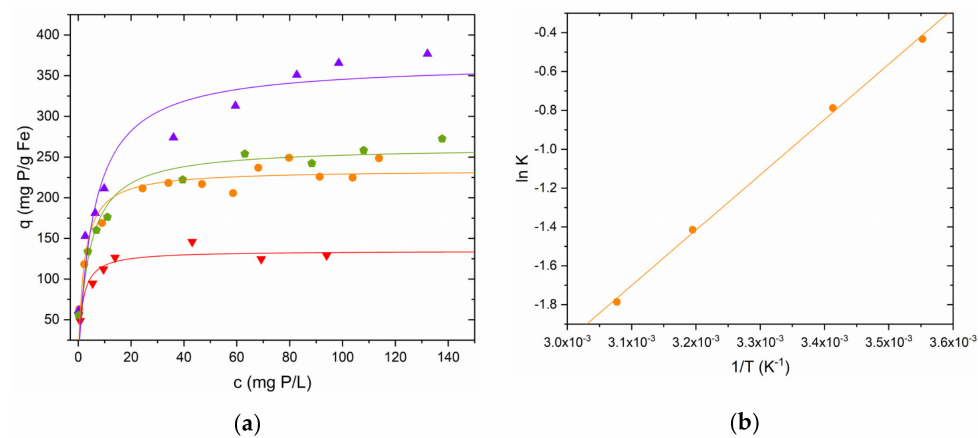
Figure 8. ( a ) Influence of temperature on phosphorus adsorption using GSP-Fe S-1. Dose 2 g · L − 1 , equivalent to 47.4 mg Fe · L − 1 . ( (cid:72) ) 8.5 ◦ C, ( • ) 20 ◦ C, ( b ) Representation of ln K vs 1/T according to van 't Hoff equation. Table 4. Sorption parameters obtained from the Langmuir model for phosphorus adsorption on GSP-Fe at several temperatures.